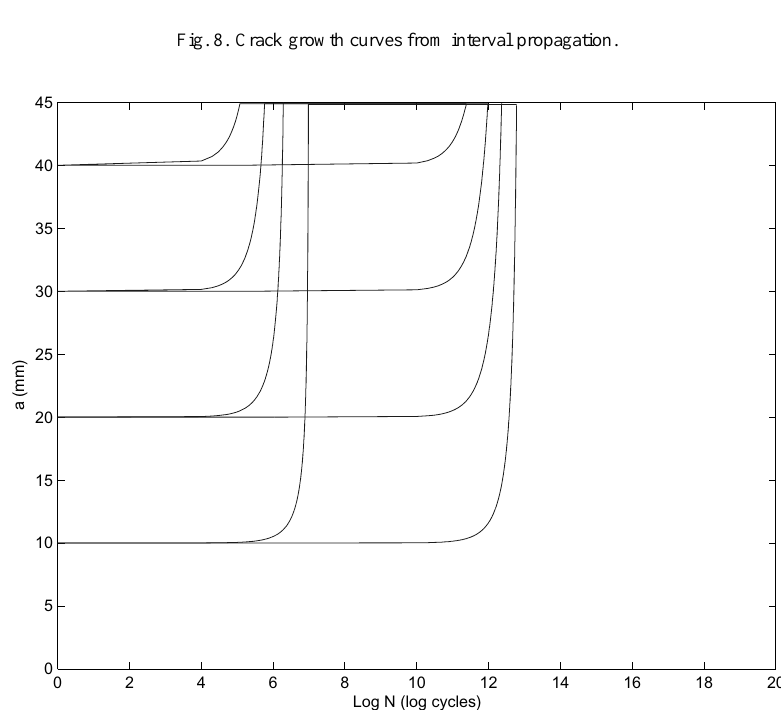
Fig. 9. Crack growth curves starting from different initial